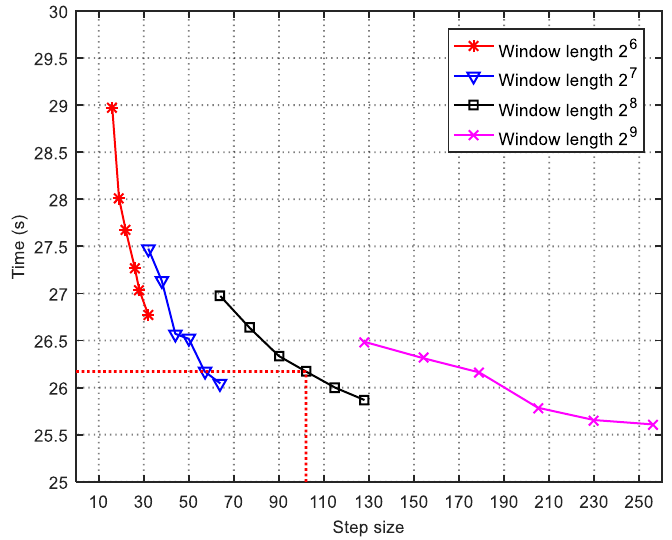
Figure 6. The experimental time required for different step sizes in the four window lengths.